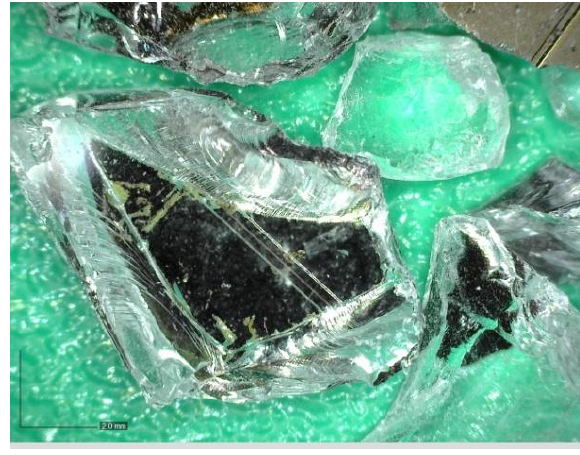
Figure 4. Glass recyclate fraction 4/10 mm; 51× magnified.